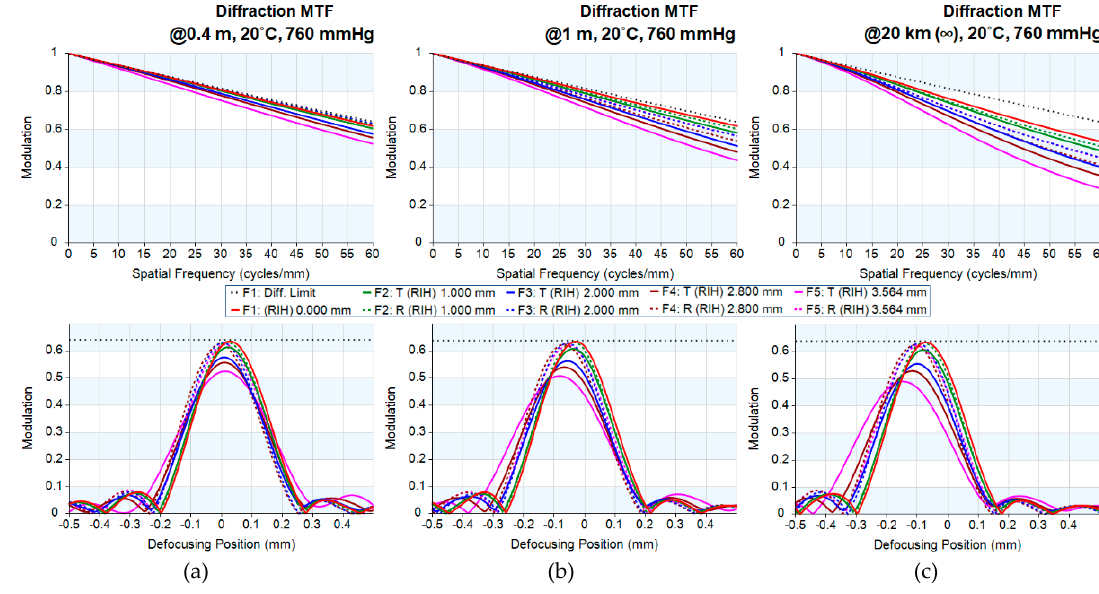
Figure 4. MTF and the through-focus MTF of the lenses at object distances of ( a ) 0.4 m, ( b ) 1 m, and ( c ) infinity (20 km) under NTP conditions.